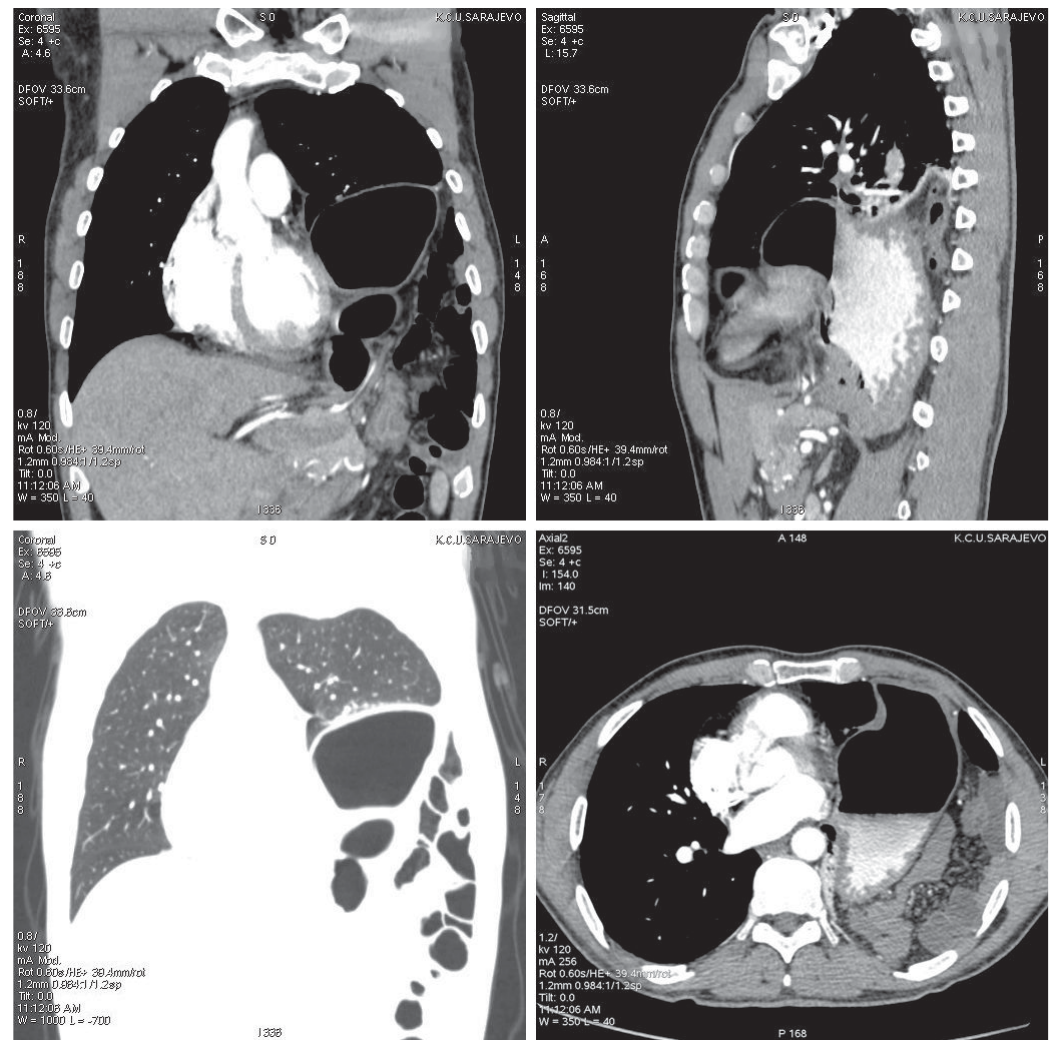
FIGURE 6. Spontaneous rupture of the diaphragm with the herniation of stomach and intestine in the left